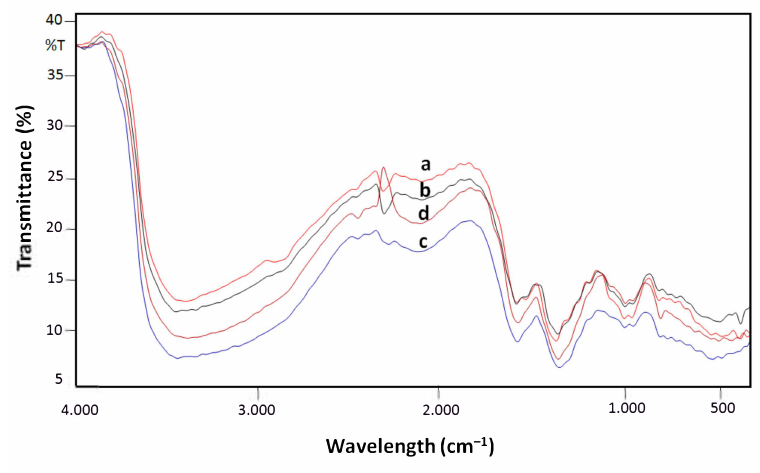
Figure 4. Characterization of the FT-IR spectra of AgNPs-chi-spheres. FT-IR AgNPs-chi-spheres. a. AgNPs-chi-spheres with NaOH 20%; b. AgNPs-chi-spheres with NaOH 30%; c. AgNPs-chi-spheres with NaOH 40%; d. AgNPs-chi-spheres with NaOH 50%.